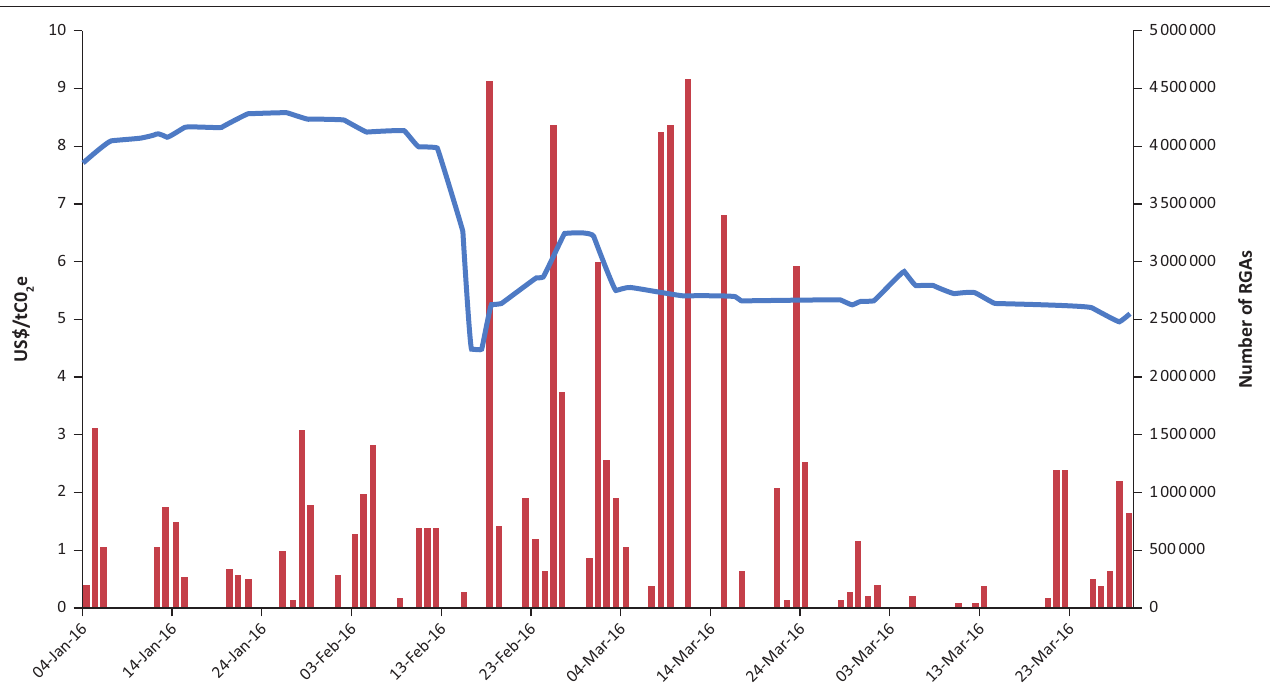
Source : Figure generated in Thomson Reuters Eikon 2016 FIGURE 2: The spot price of RGAs traded in US$/tCO